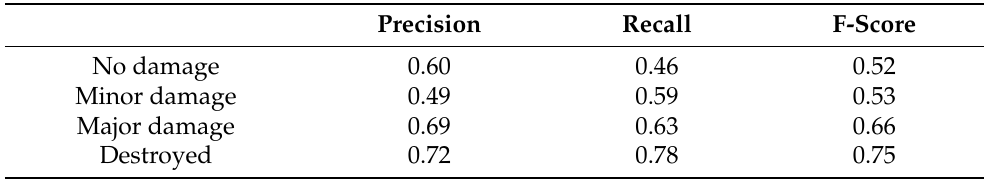
Table 8. Performance metrics for Model 3 (oversampling strategy).